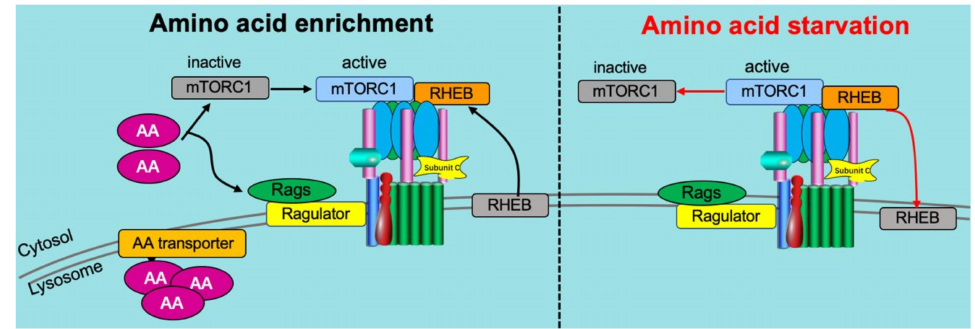
Figure 5. v-ATPase-dependent amino acid signaling. (1) Under conditions of high amino acid (AA) availability ( left panel ), intralysosomal AA activates the ragulator complex, which acts as a GEF toward the Rag GTPases (Rags), activating them. The Rag GTPases are anchored to the lysosomal membrane by the Ragulator complex bound to the V-ATPase. Subsequently, the inactive mammalian target of rapamycin complex 1 (mTORC1) is recruited to the lysosomal membrane by the active Rag GTPases, where it can be activated by the lysosomal Rheb GTPases. (2) Under low AA conditions ( right panel ), Ragulator GEF activity is inhibited, inactivating Rags, and leading to the disassociation from the lysosome and inactivation of mTORC1. Adapted from